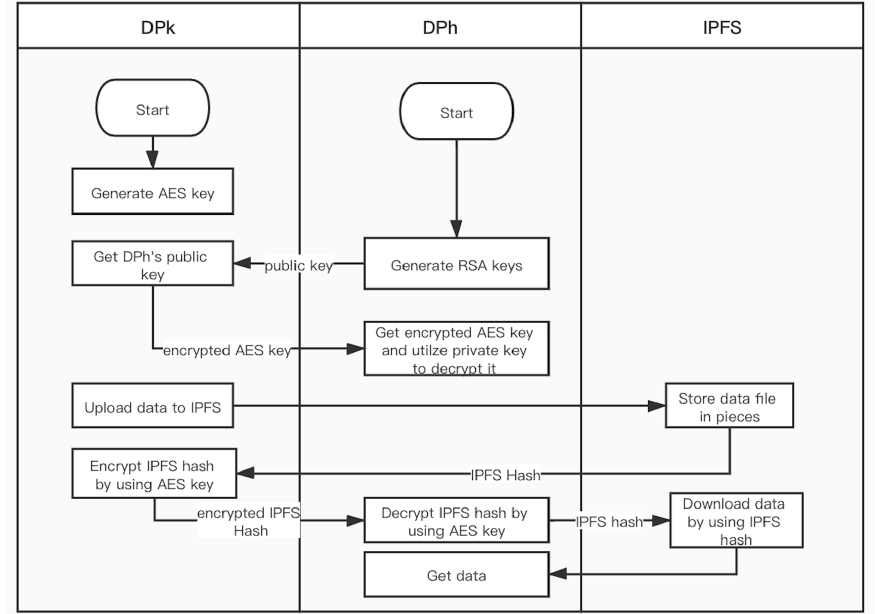
Figure 4. Workflow of IPFS data sharing